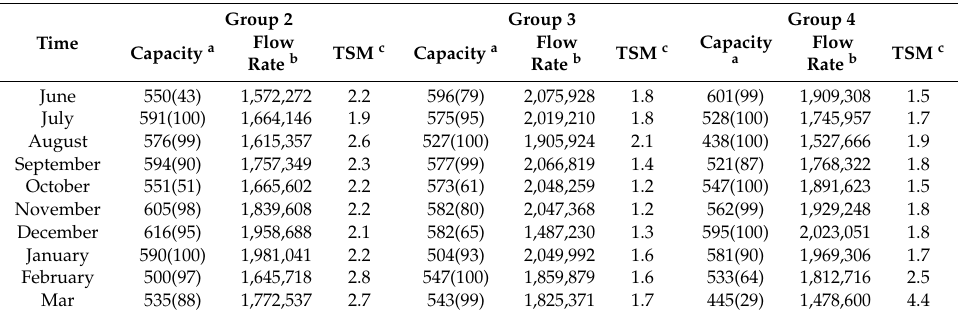
Table 1. Main Plant Operation during the Entire Sampling Campaign (June 2015–March 2016).